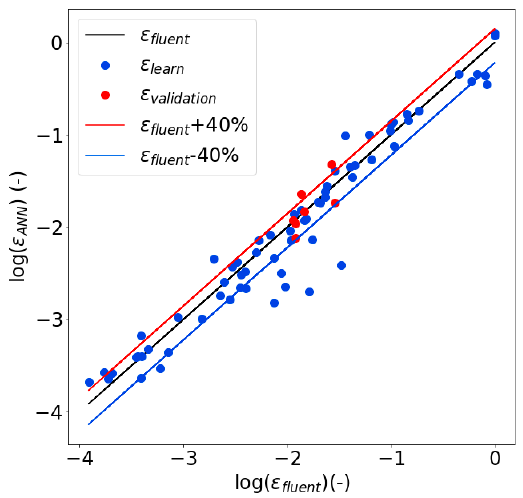
Figure 3. Results of the training of the artificial neural network (ANN), the results of void fraction of the ANN ε ANN are compared to the void fraction calculated to ε fluent . The blue points represent the learning samples and the red points the validation samples. The red line is ε fluent + 40% and the blue line ε fluent −